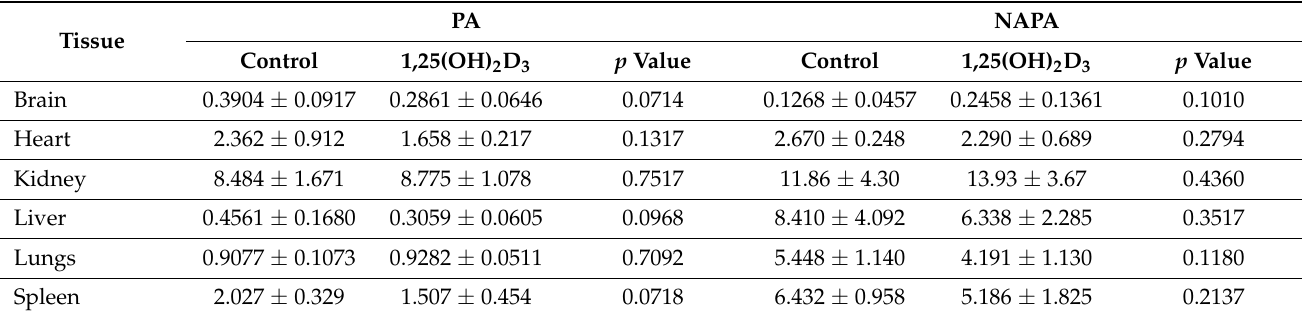
Table 2. Tissue-to-plasma partition coefficient at steady state ( K p , ss ) for PA and NAPA in major tissues from control and 1,25(OH) 2 D 3 -treated rats. Data are represented as the mean ± S.D. ( n = 5). Tissue